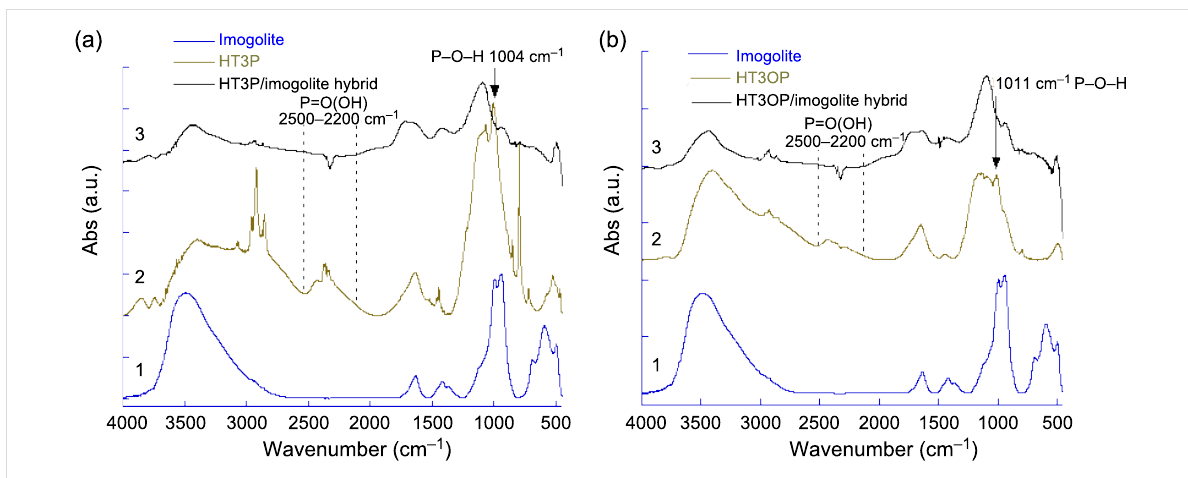
Figure 16: FTIR spectra (a) of HT3P/imogolite hybrid, HT3P, and imogolite, (b) of HT3OP/imogolite hybrid, HT3OP, and imogolite. Reprinted with permission from W. O. Yah et al., Bull. Chem. Soc. Jpn. 2011, 84, 893–902 [60]. © 2011, The Chemical Society of Japan.